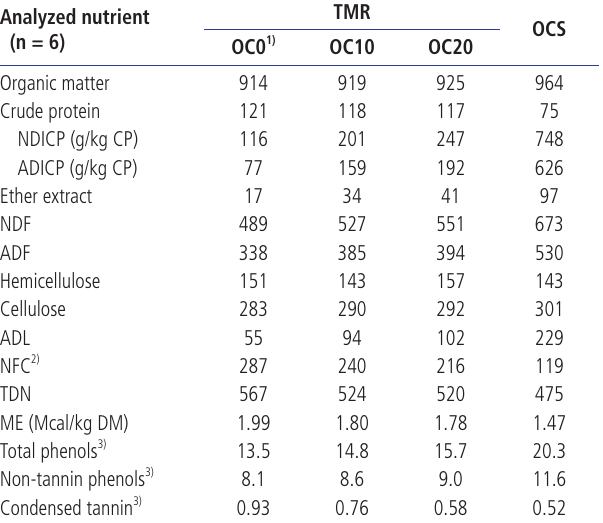
Table 2. Nutritive value of the experimental TMR and OCS (g/kg DM) Analyzed nutrient (n = 6)